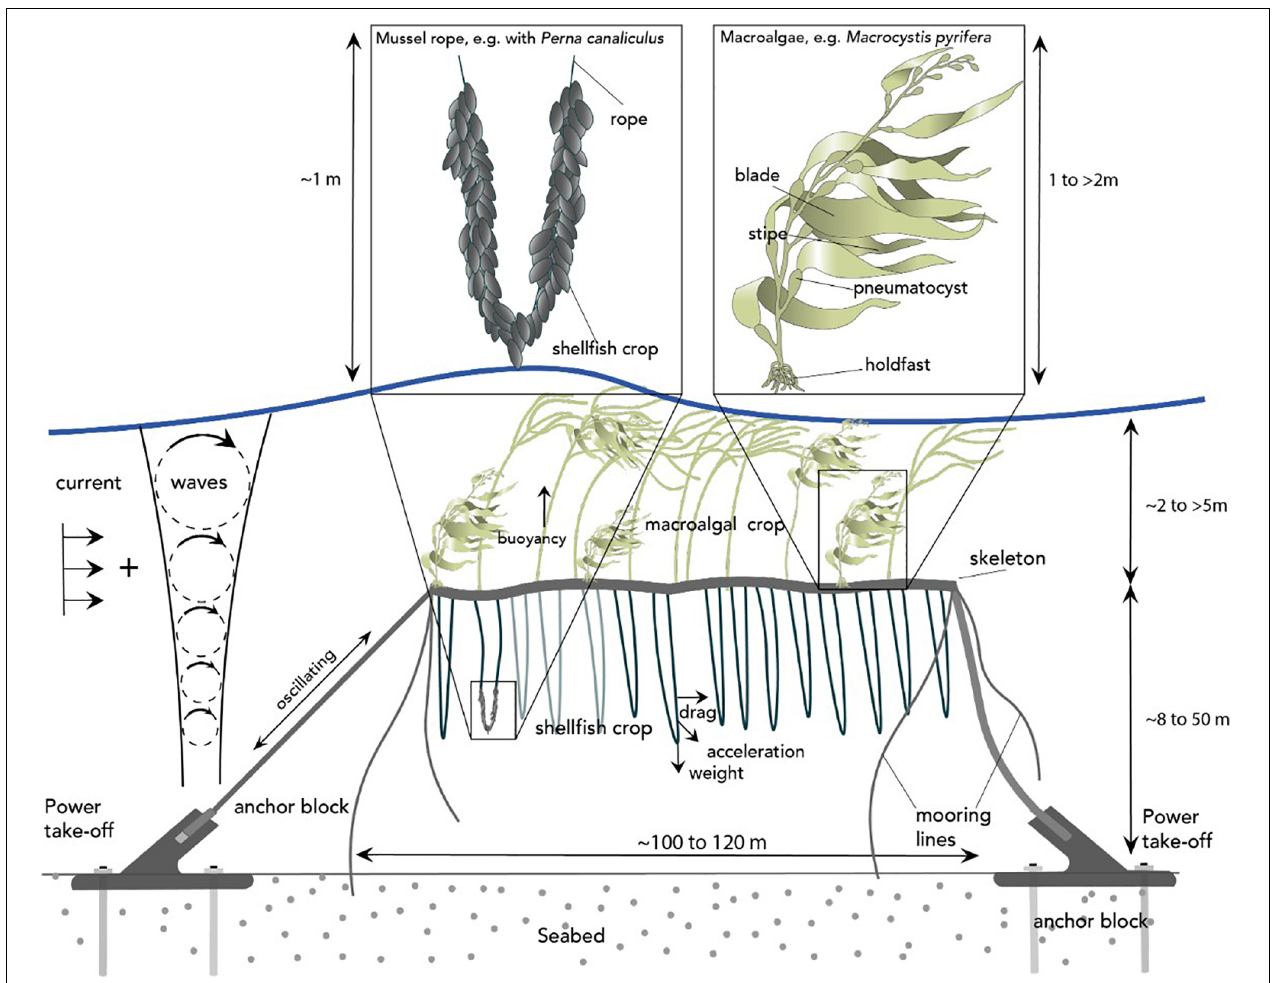
FIGURE 1 | Schematic of initial concept showing the skeleton, anchors, and biological options in a wave-current